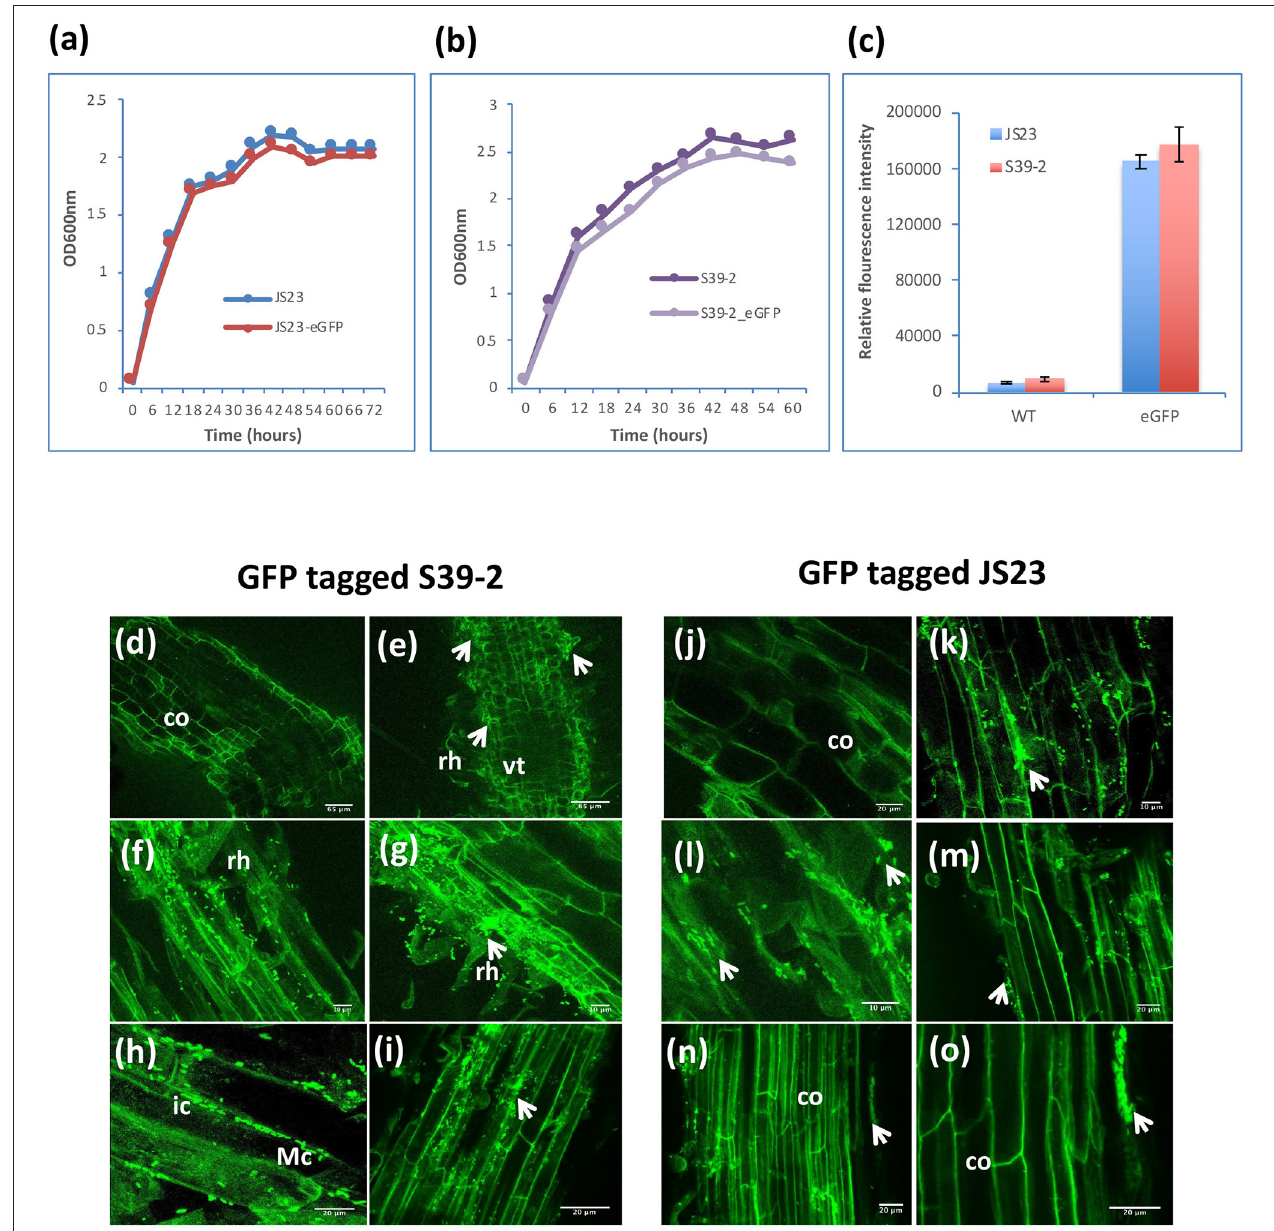
FIGURE 3 | Colonization of GFP-tagged S39-2 and JS23 T . (a, b) Cell density of wild-type (WT) and GFP-tagged JS23 T and S39-2 in liquid culture (2xYT medium). (c) Relative fluorescence intensity of WT and GFP-tagged cells in culture medium was quantified in Tecan plate reader (Tecan i-Control, infinite 200; 476nm excitation wavelength and 506nm emission wavelength) using 96 flat bottom white polystyrol plate (Corning). Error bars are standard deviations ( n = 3). (d, j) uninoculated roots. (e–i) Root tissues inoculated with S39-2-gfp on 15 DAI (d–f) and 45 DAI (h, i) . (k–o) JS23 T -gfp inoculated root tissues on 15 DAI (k, l) and 45 DAI (m–o) . DAI, days after inoculation; rh, root hairs; co, cortical cells; arrowhead indicate micro-colonies (Mc); vt, vascular tissue; ic, intercellular colonization. Scale bars = 10 µ m (f, g, k, and l) , 20 µ m (h, i, j, m, n, and o) , and 65 µ m (d, e)